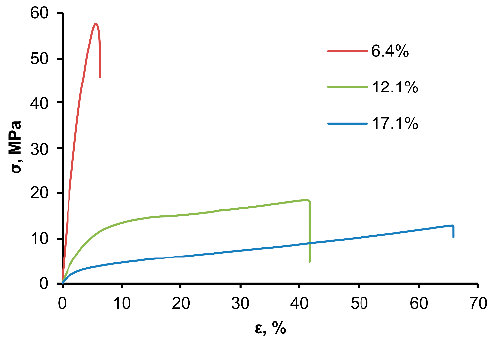
Figure 5 . The mechanical characteristics of OSTE-MS polymers. Figure 5. The mechanical characteristics of OSTE-MS